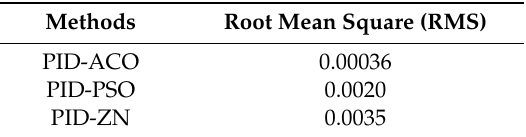
Table 4. Root mean square error (RMS) error of proposed PID-ACO to compare with PID-ZN and